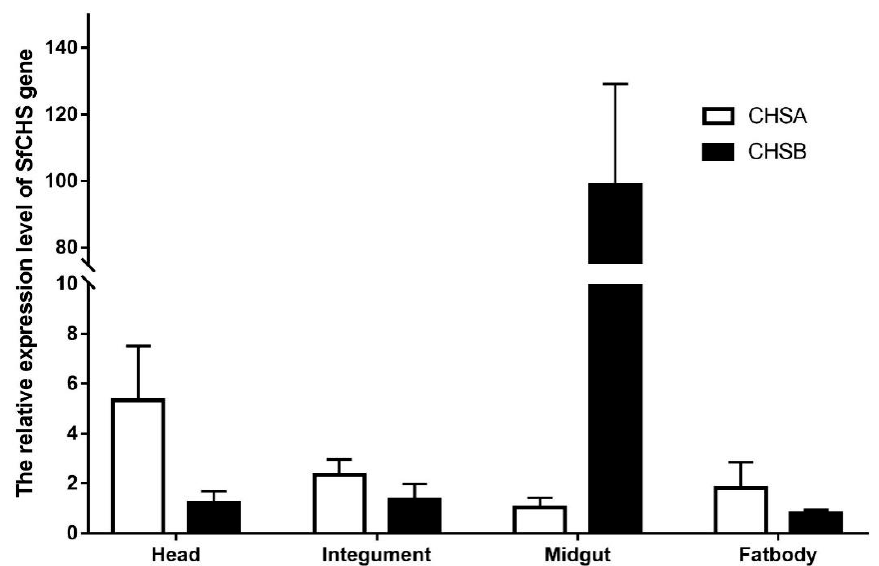
Figure 3. Relative expression levels of chitin synthase genes (SfCHSA and SfCHSB) in different tissues of Spodoptera frugiperda. Note: the lowest expression is ascribed an arbitrary value of 1; expression levels in integument, midgut, head, and fat body were detected by qPCR.